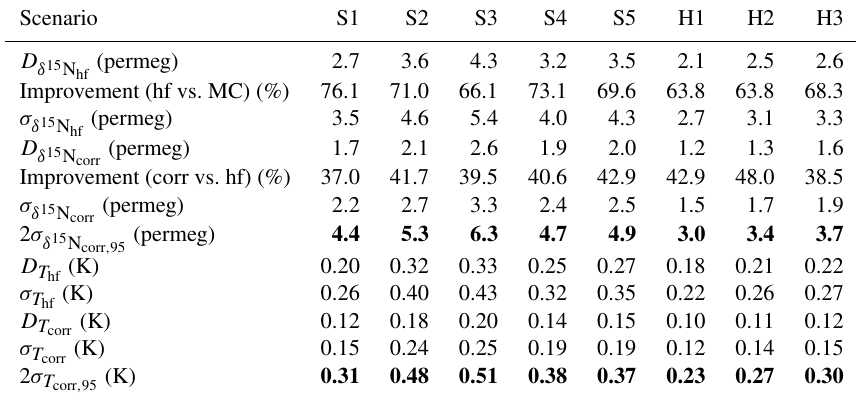
) of the modelled δ 15 N mc versus synthetic target δ 15 N syn as function of the number of Figure 6. Evolution of the mean misfit ( D δ 15 N mc iterations ( j ) for the Monte Carlo approach for all synthetic target scenarios. Table 4. Summary for the high-frequency (hf) and correction part (corr) of the reconstruction approach. D is the mean mismatch between the modelled δ 15 N (or temperature) data and the synthetic δ 15 N (or temperature) target. σ is the standard deviation of the pointwise mismatches σ T D i . The 95% quantiles (2 σ ) of the pointwise δ 15 N (or temperature) mismatches are used as an estimate for the 2 σ δ 15 N corr , 95 or 2 corr , 95 uncertainty for the final solution (values in